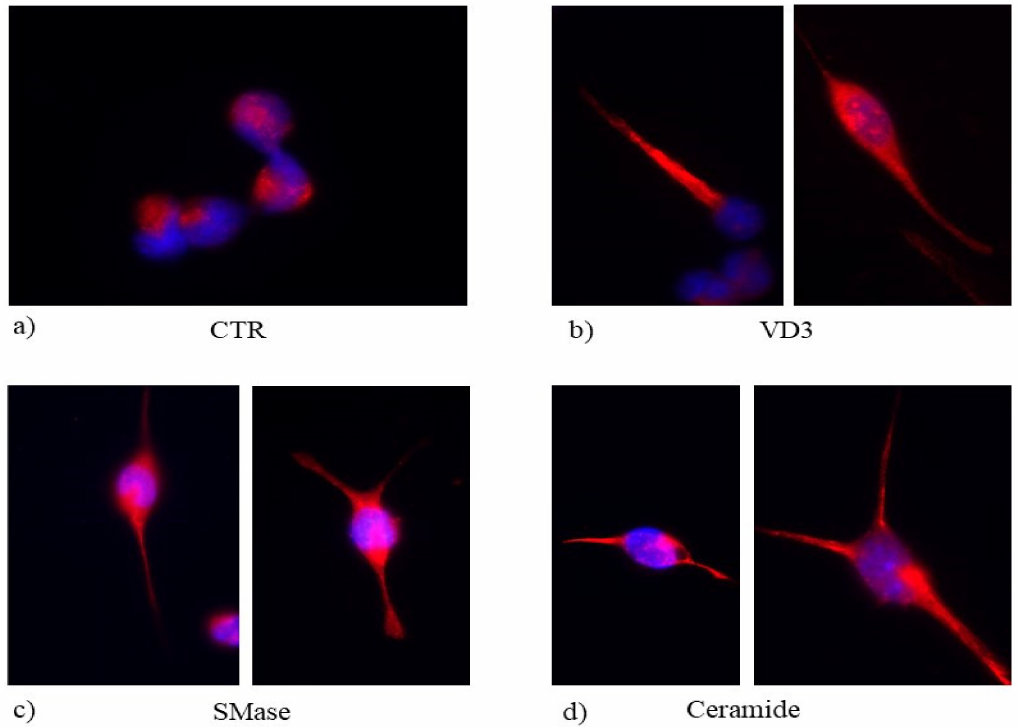
Figure 7. Immunofluorescence of H9.10e cells without (CTR, ( a ) or with VD3 ( b ), SMase ( c ) and ceramide ( d ). The image represents the merged signal of GFAP immunolabelling, in red, counterstained with DAPI (in blue). 100 ×